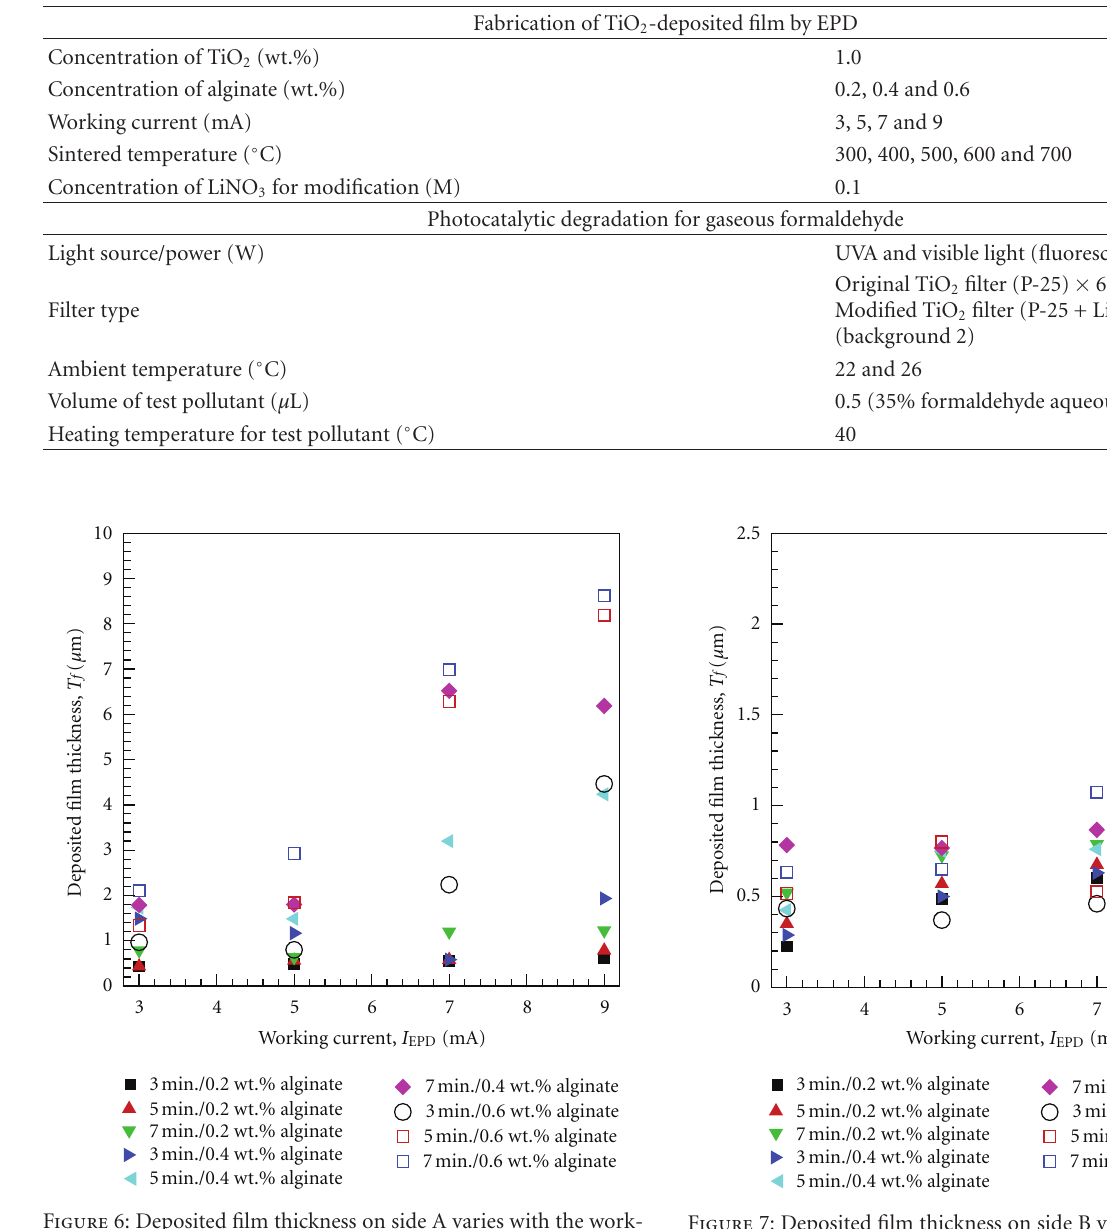
Table 1: List of the experimental parameters.